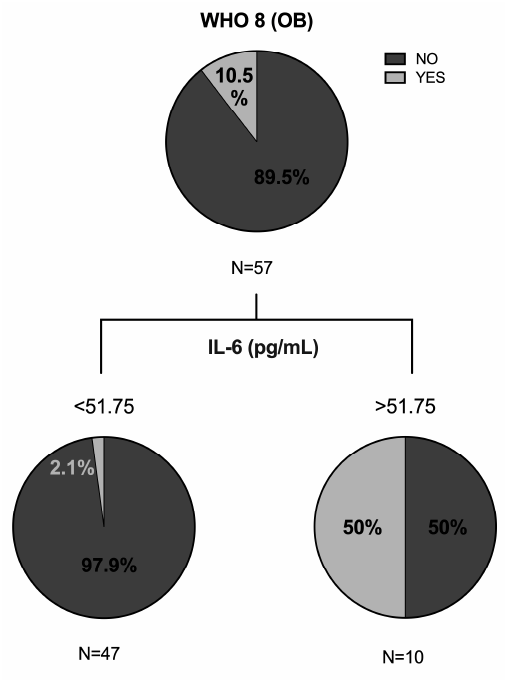
Figure 2. Classification and regression tree of the cohort with obesity were elaborated through CRT method for variable WHO 8 of severe pneumonia by COVID-19, namely: death. OB: obesity; IL-6: interleukin 6.